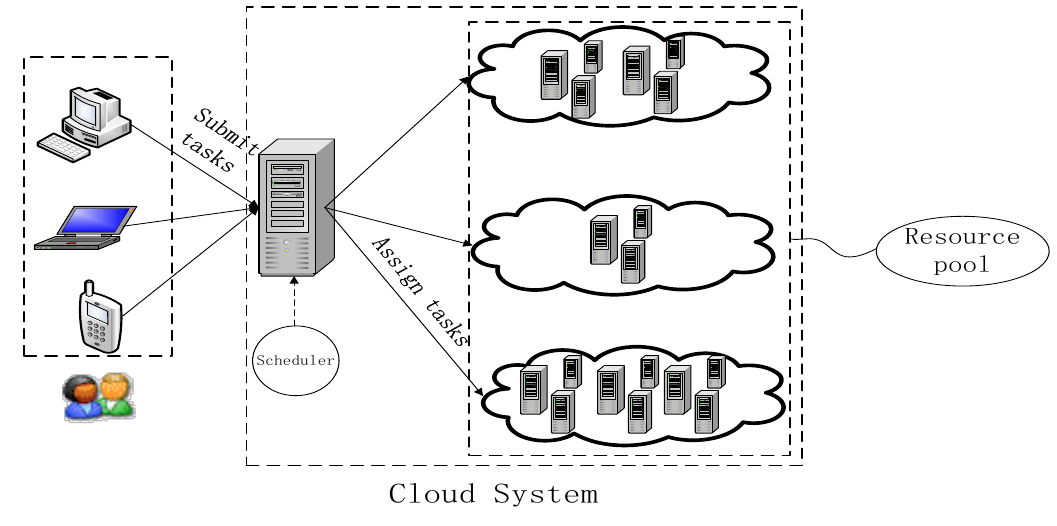
Figure 1. The main process of task scheduling.